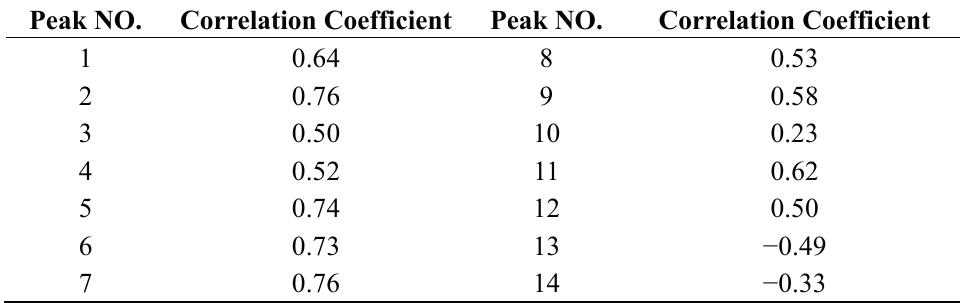
Table 2. The correlation coefficient between UA-lowering and common characteristic peaks. Peak NO. Correlation Coefficient Peak NO.